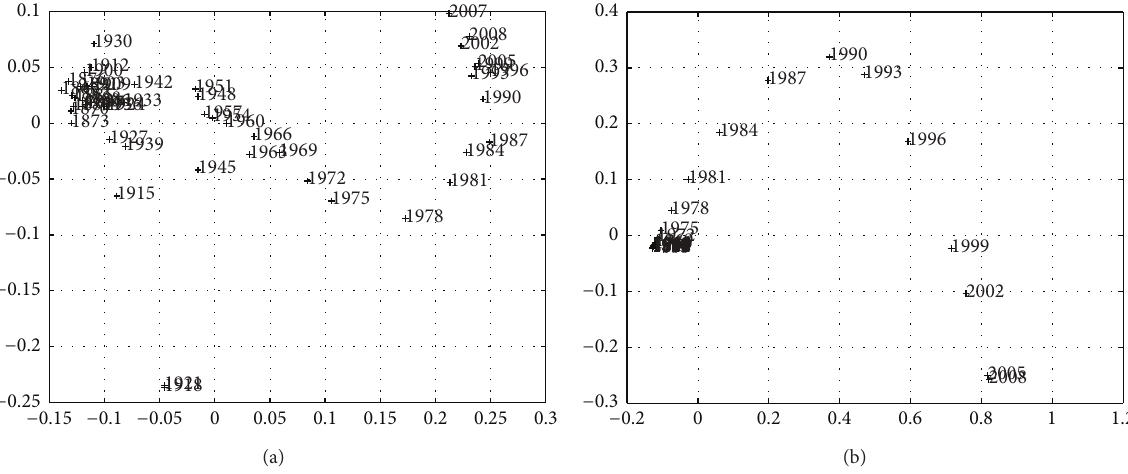
Figure 9: Two-dimensional MDS maps of the Portuguese economic evolution: 𝑇 = 1865 – 2010 , ℎ = 3 years for 𝑟 𝐶 (a) and 𝑟 𝐸 (b).